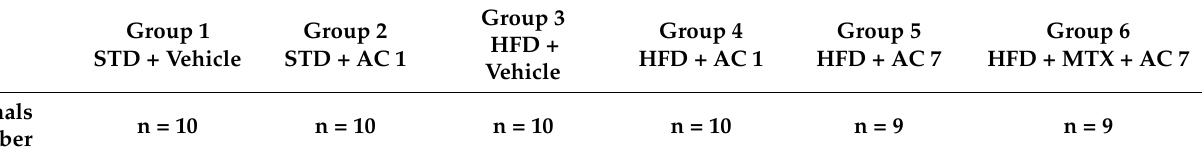
Table 11. Deviations from the norm revealed during microscopic analysis in organs and